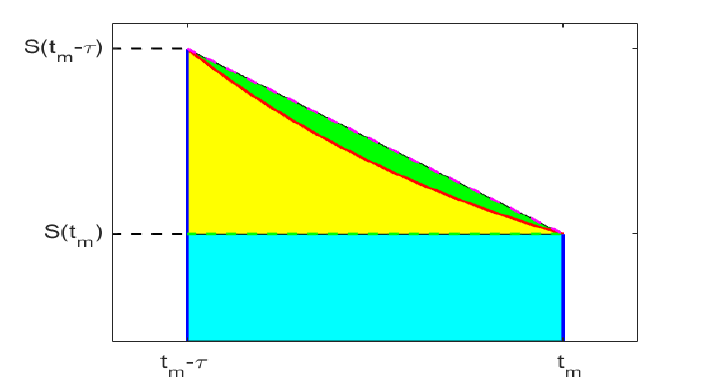
(cid:82) t m S ( t ) dt , i.e., the area under the red curve t m − τ